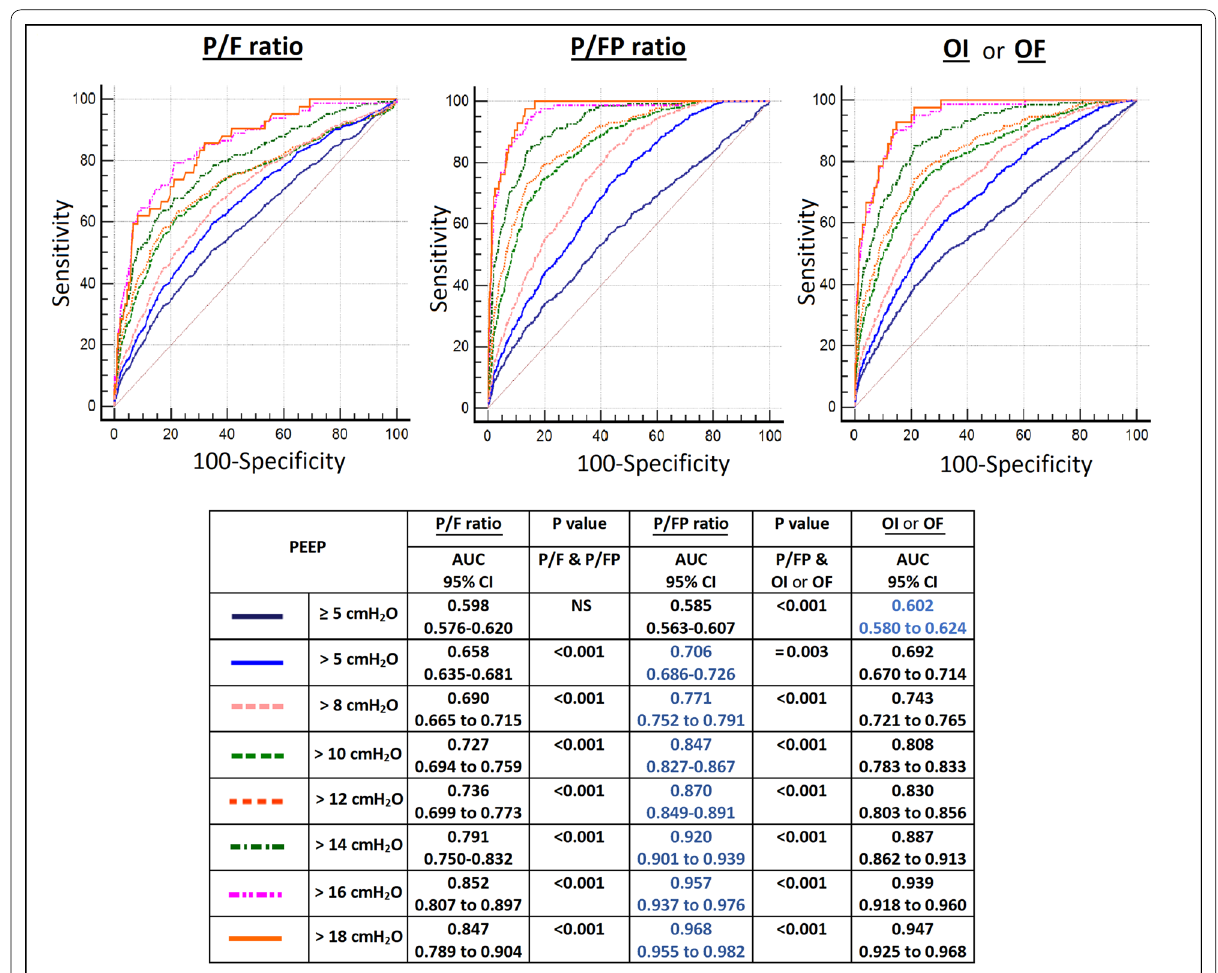
Fig. 1 Receiver operating curves for hospital mortality at different PEEP thresholds for 3191 patients from our study [1], after excluding those with missing mean airway pressure values. Abbreviations: P/F, ratio of the partial pressure of arterial oxygen (PaO2) to the fraction of inspired oxygen (FiO2); P/FP (PaO2*10)/(FiO2*PEEP); OI, oxygenation index (FiO2*MAP)/PaO2; OF, oxygenation factor (PaO2/(FiO2*MAP); PEEP, positive = = = end-expiratory pressure; AUC, area under the curve; CI confidence interval; NS, not